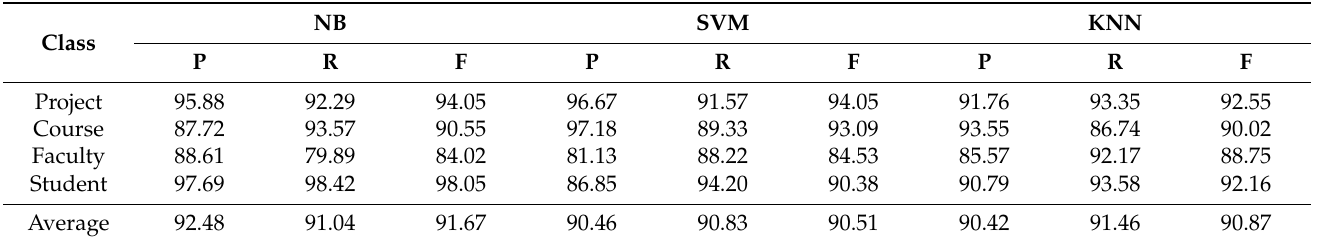
Table 14. Precision (P), Recall (R) and F-measure (F) of each class in the WebKB dataset using BBA CO